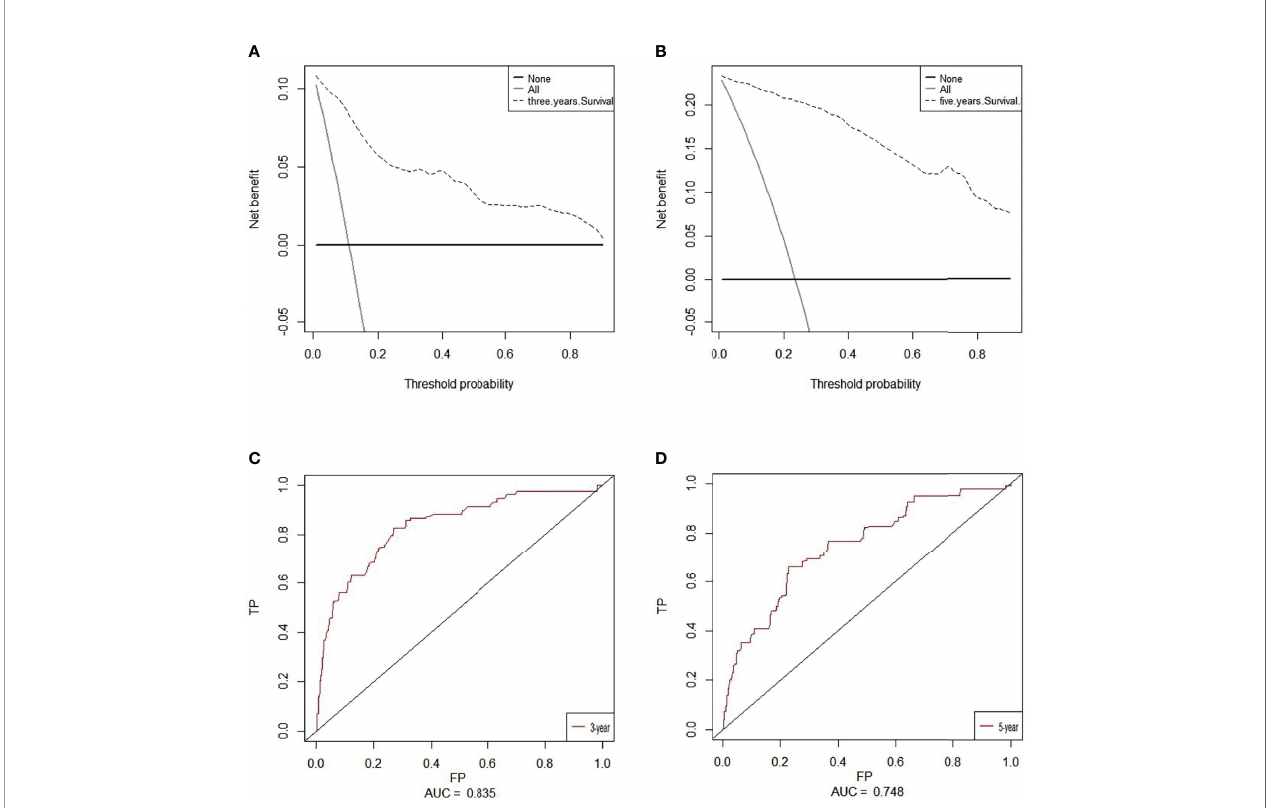
FIGURE 6 | Decision curve analysis (DCA) of the nomogram of based on 3-year (A) and 5-year (B) overall survival. The x-axis and the y-axis were the threshold probability and the net bene fi t, respectively. Receiver operating characteristic (ROC) analyses of the nomogram based on 3-year (C) and 5-year (D) overall